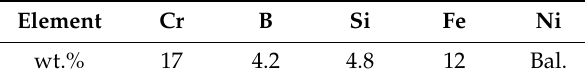
Table 1. Chemical composition of Ni60 powder.